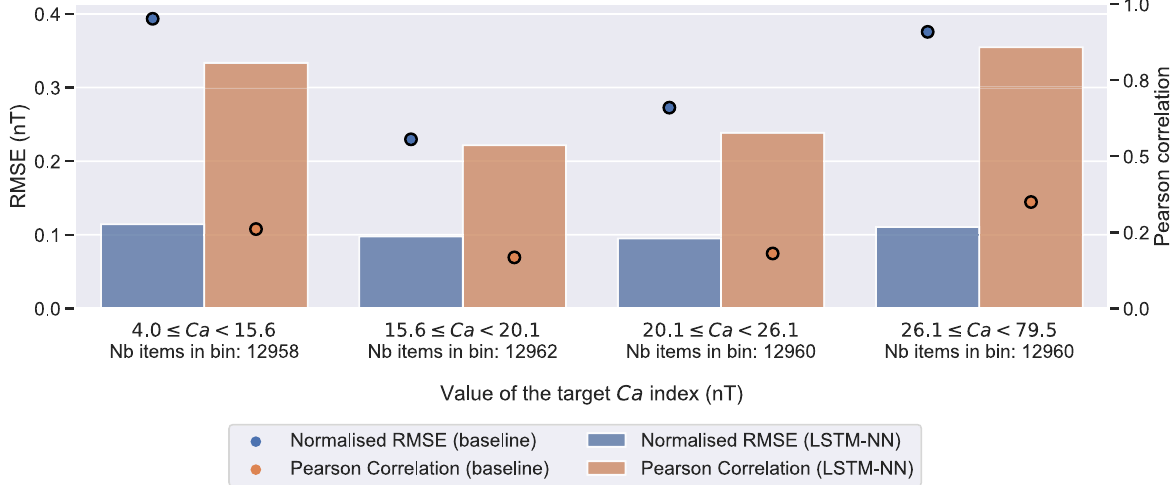
Fig. 7. Normalised RMSE and Pearson correlation of the 3-h ahead predicted values versus binned observed values. Each bin contains a quarter of the total observations in the test set. Table 3. Evaluation of the NN-based and the baseline models in the context of the classi fi cation problem. Time horizon (h) Precision Recall F score